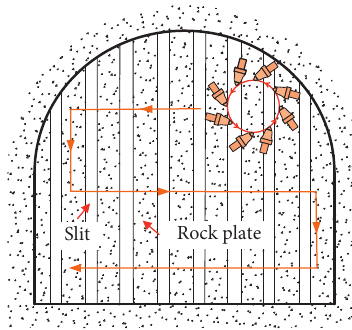
Figure 1: Schematic drawing of the application of the new rock cutting method.